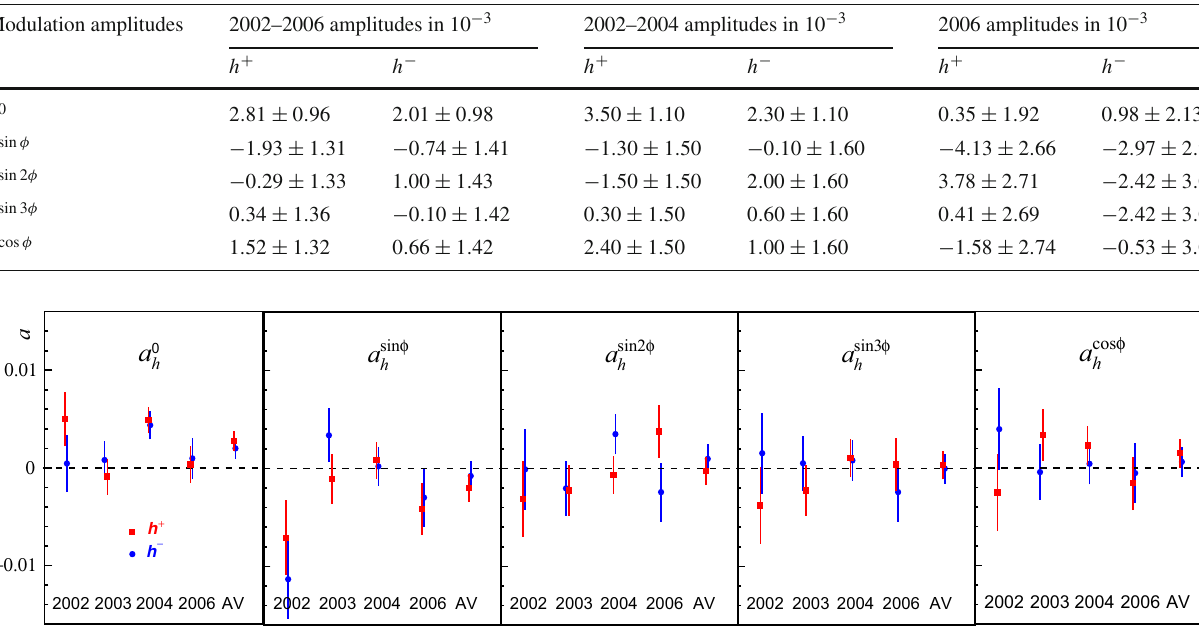
2003, 2004 and 2006 as well as statistically combined modulation amplitudes for four years denoted by AV (see Sect. 4.1)